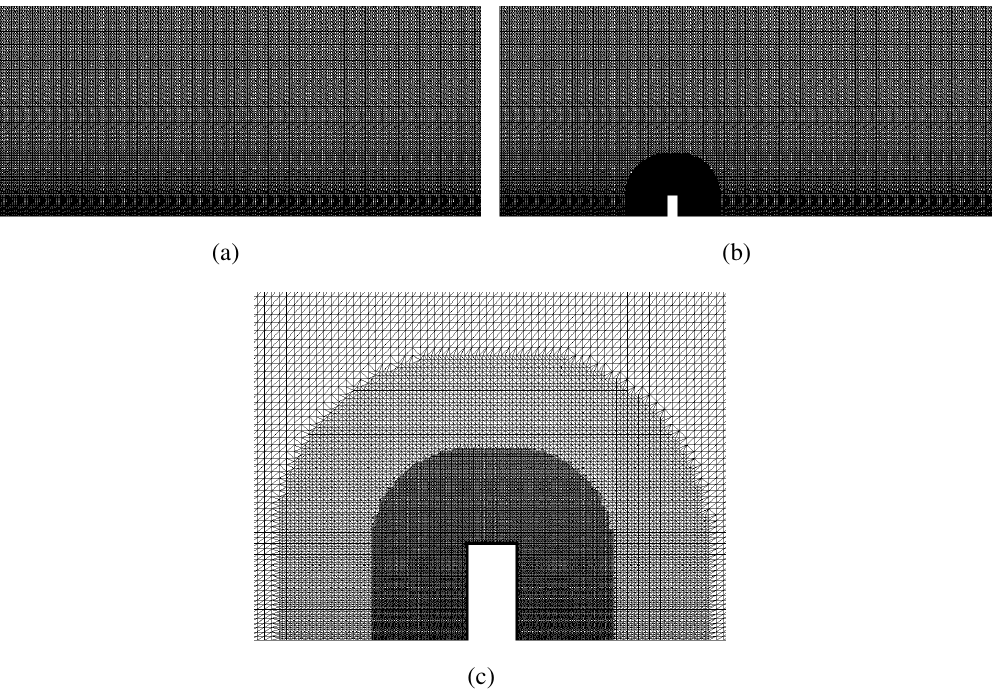
Figure 9. Vertical section of the refined mesh obtained using snappyHexMesh . ( a ) Vertical section of the external mesh (3.3 M cells); ( b ) general view of the final flat roof mesh (6.7 M cells); ( c ) detail of the mesh refinement around the flat roof